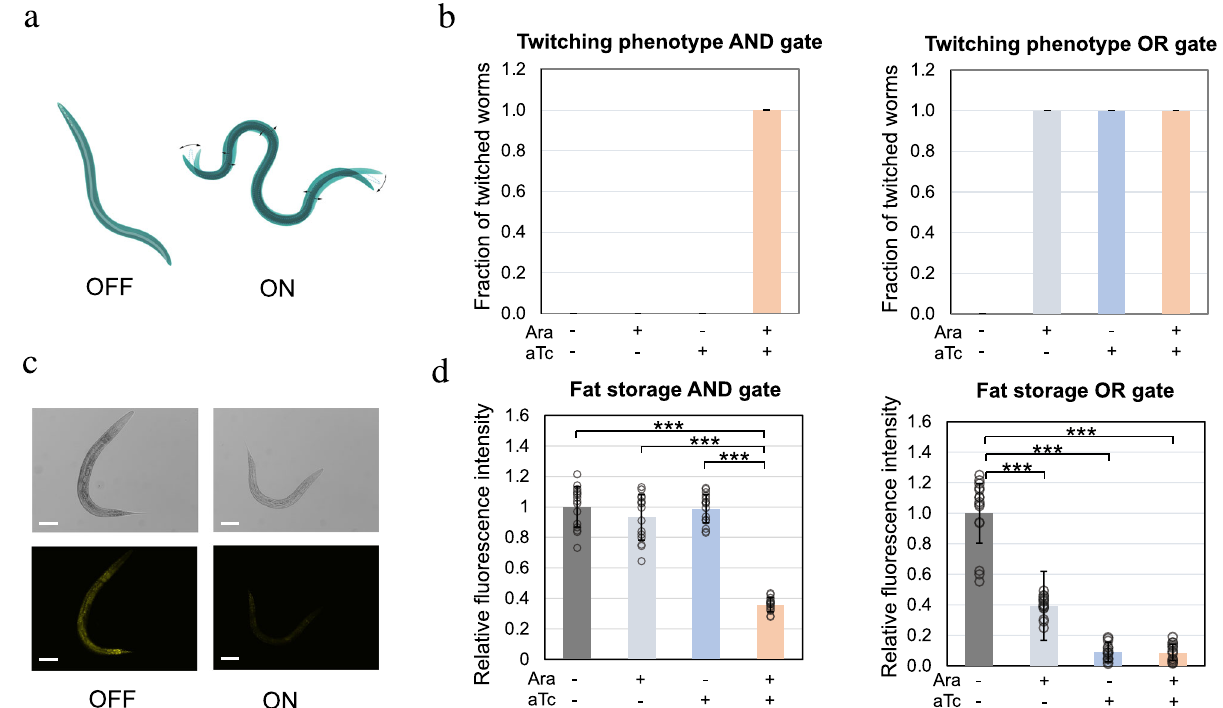
Fig. 4 Worm twitching phenotype and fat storage programming through engineered bacteria. a Schematic of twitching phenotype RNAi in C. elegans . b C. elegans twitching phenotype in response to AND and OR gate programming through bacteria expressing 200 bp and 400 bp double-stranded unc-22 RNA. c Reduced fat storage due to sbp-1 silencing, indicated by Nile Red staining. Scale bar, 100 µ m. The experiment was repeated three times independently for a total of 15 worms with similar results. d AND and OR gate-controlled C. elegans metabolism through sbp-1 RNA. (*** P < 0.001 using two-sided t -test with Bonferroni correction. Error bars represent the mean ± standard deviation for n = 200 worms over three independent experiments for twitching phenotype, and n = 15 worms over three independent experiments for fat storage) Source data are available in the Source Data fi